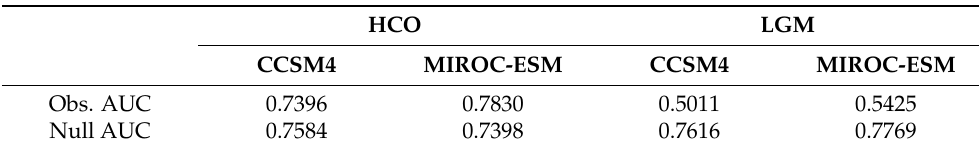
Table A2. Evaluation of the SDM of Cedrus atlantica projected into the past: observed and null model AUC.